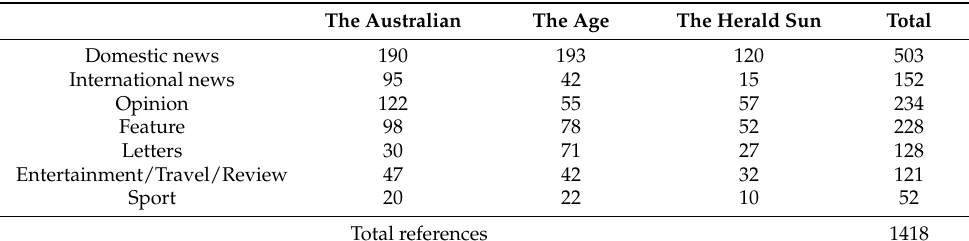
Table 4. References based on news genre across the